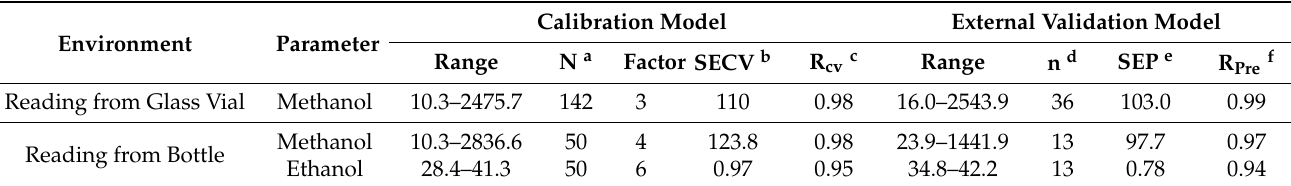
a number of samples used in the calibration models, b standard error of cross-validation, c correlation coefficient of cross-validation, d number of samples used in external validation models, e standard error of prediction, f correlation coefficient of prediction for external